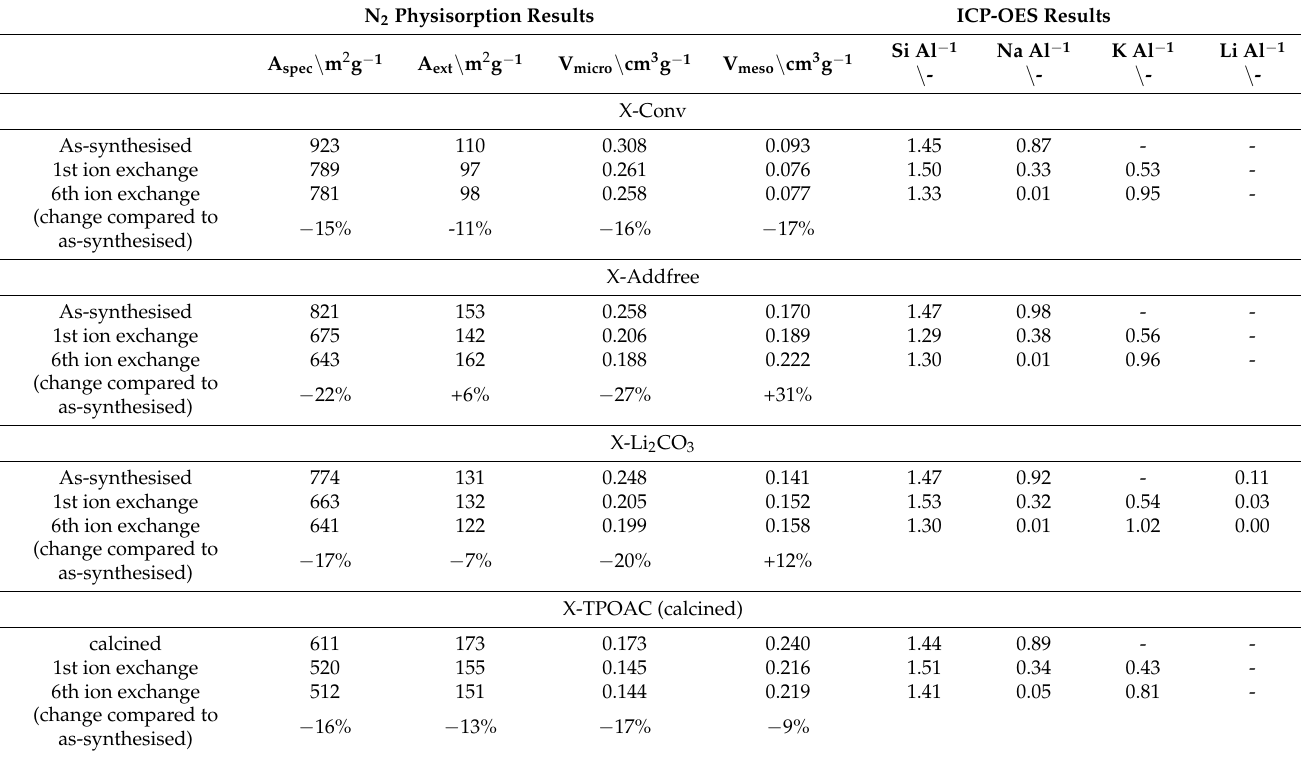
Table 1. Textural data from N 2 physisorption and elemental molar ratios from ICP-OES of all four zeolites with different morphologies before and after the 1st and 6th ion exchange. (- = not determined).